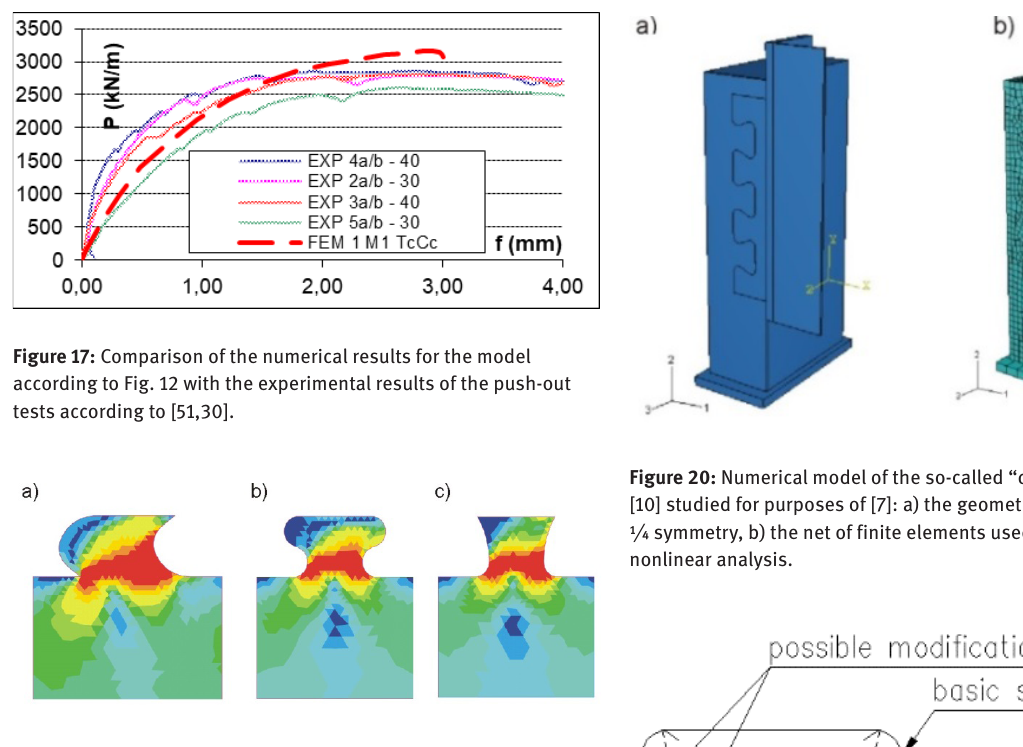
Figure 18: Steel shapes studied by SETRA at early stages of project [7] presenting yielding of plane models (reduced stress layouts): a) fin shape, b) early version of puzzle shape, c) one of the shapes that has been studied but was never used for testing.